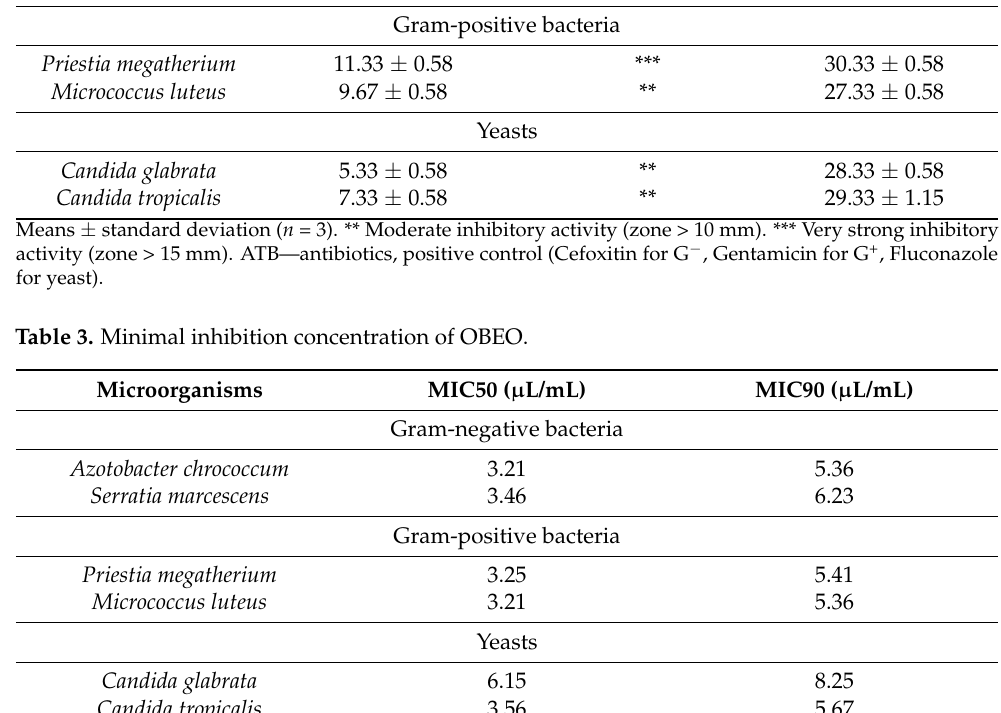
Table 4. In situ analysis of the antibacterial activity of the vapor phase of OBEO on apples.